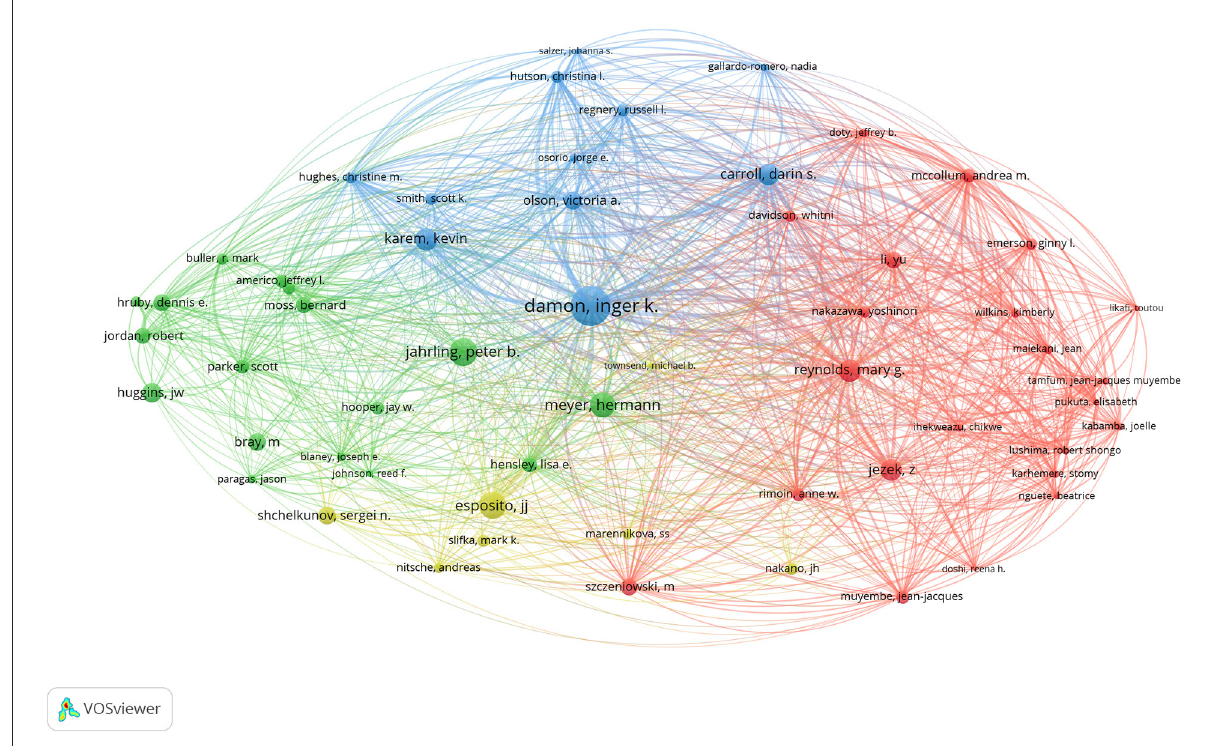
FIGURE5 Author co-citation overlay visualization map in the field of